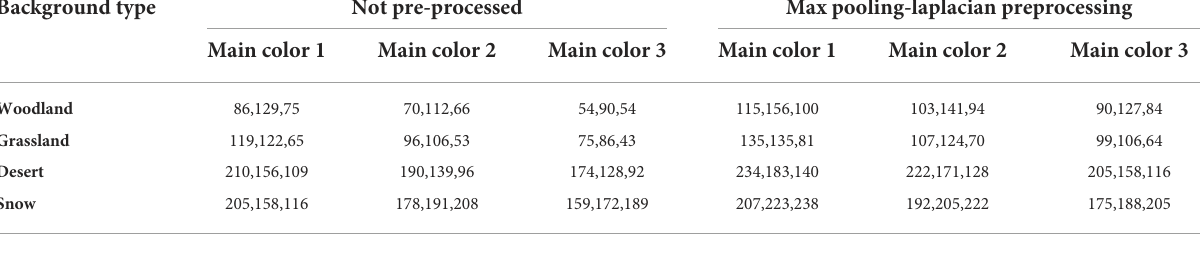
TABLE 3 Main color extraction table.